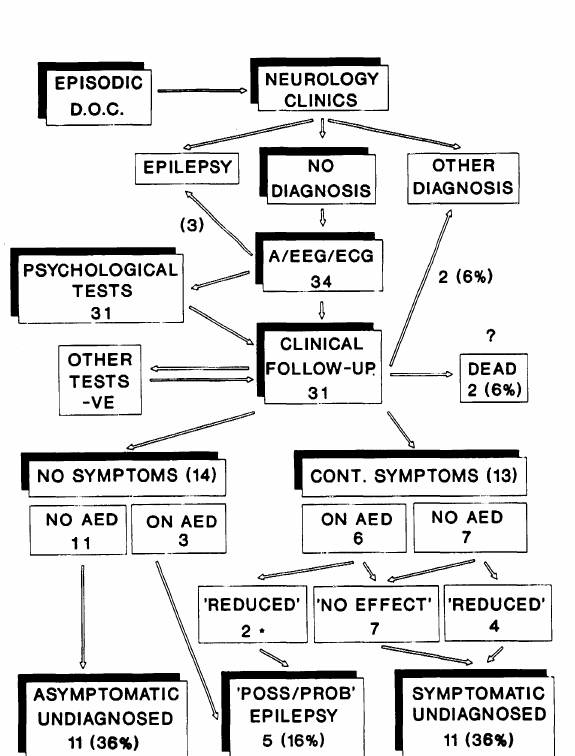
FIG. 1. Flow diagram of sequence of investigations in undiagnosed patients and outcome of clinical follow up. See textfor more details. D.D.C, symptoms of disturbances of consciousness; AED, anti epileptic medication; cont., continuing; "Reduced" and "no effect" refer to results of AED medication; ? implies uncertainty over relationship of deaths to original